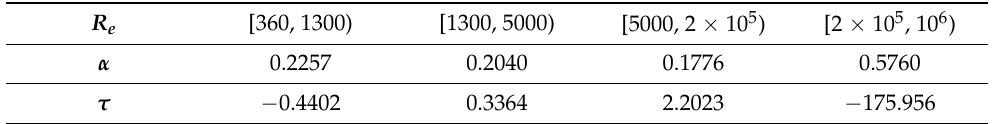
Table 3. The values of the constants α and τ , depending on the intervals of the Reynolds number, used in Equation (19) [13].